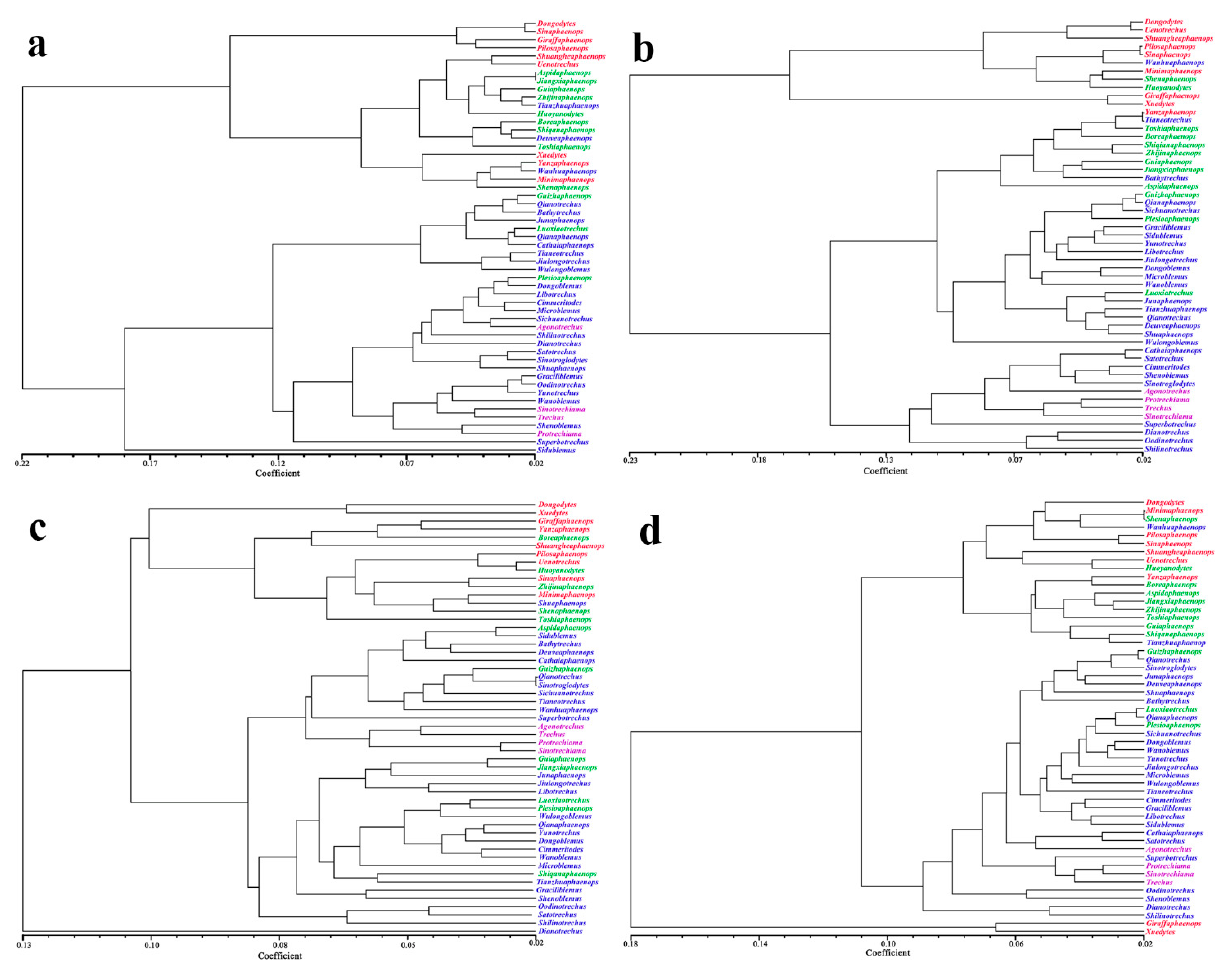
Figure 4. Phenotypic tree of ground beetle genera based on the Procrustes distance. ( a ) Head, ( b ) pronotum, ( c ) elytra, and ( d ) integrated morphology. Anphaenopsian: red letters; semi-anphaenopsian: green letters; anophthalmic: blue letters; surface-dwelling: purple letters.